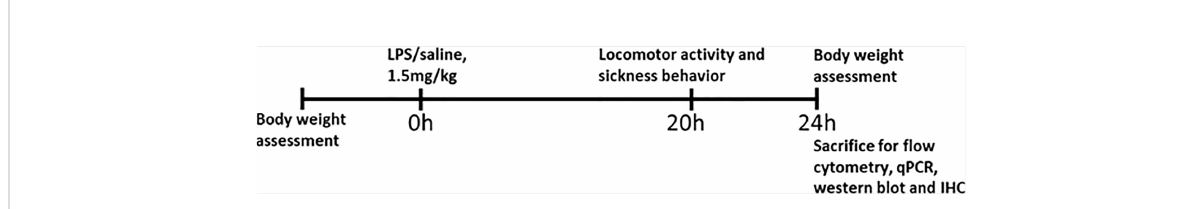
FIGURE 1 Schematic overview of the experimental